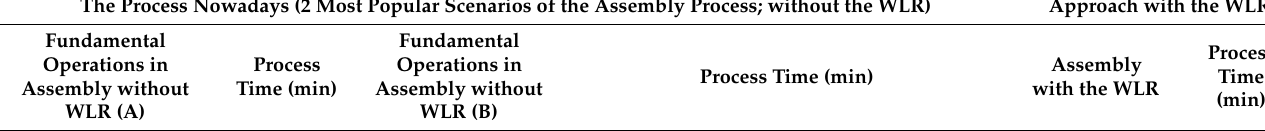
Table 1. Comparison of three alternatives in wire assembly